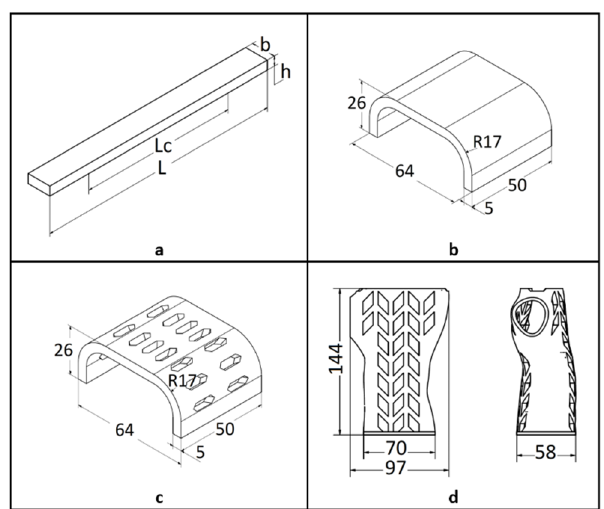
Figure 1. Dimensions of the test samples:( a ) basic sample, iso view with the marked spacing of the supports of the testing machine: Lc = 100 mm, L = 64 mm, h = 4 mm, b = 10 mm. Samples in the shape of the central part of the orthosis: ( b ) full sample—orthosis fragment, ( c ) openwork sample—orthosis fragment, ( d ) orthosis-shaped sample (wall thickness of 4 mm).